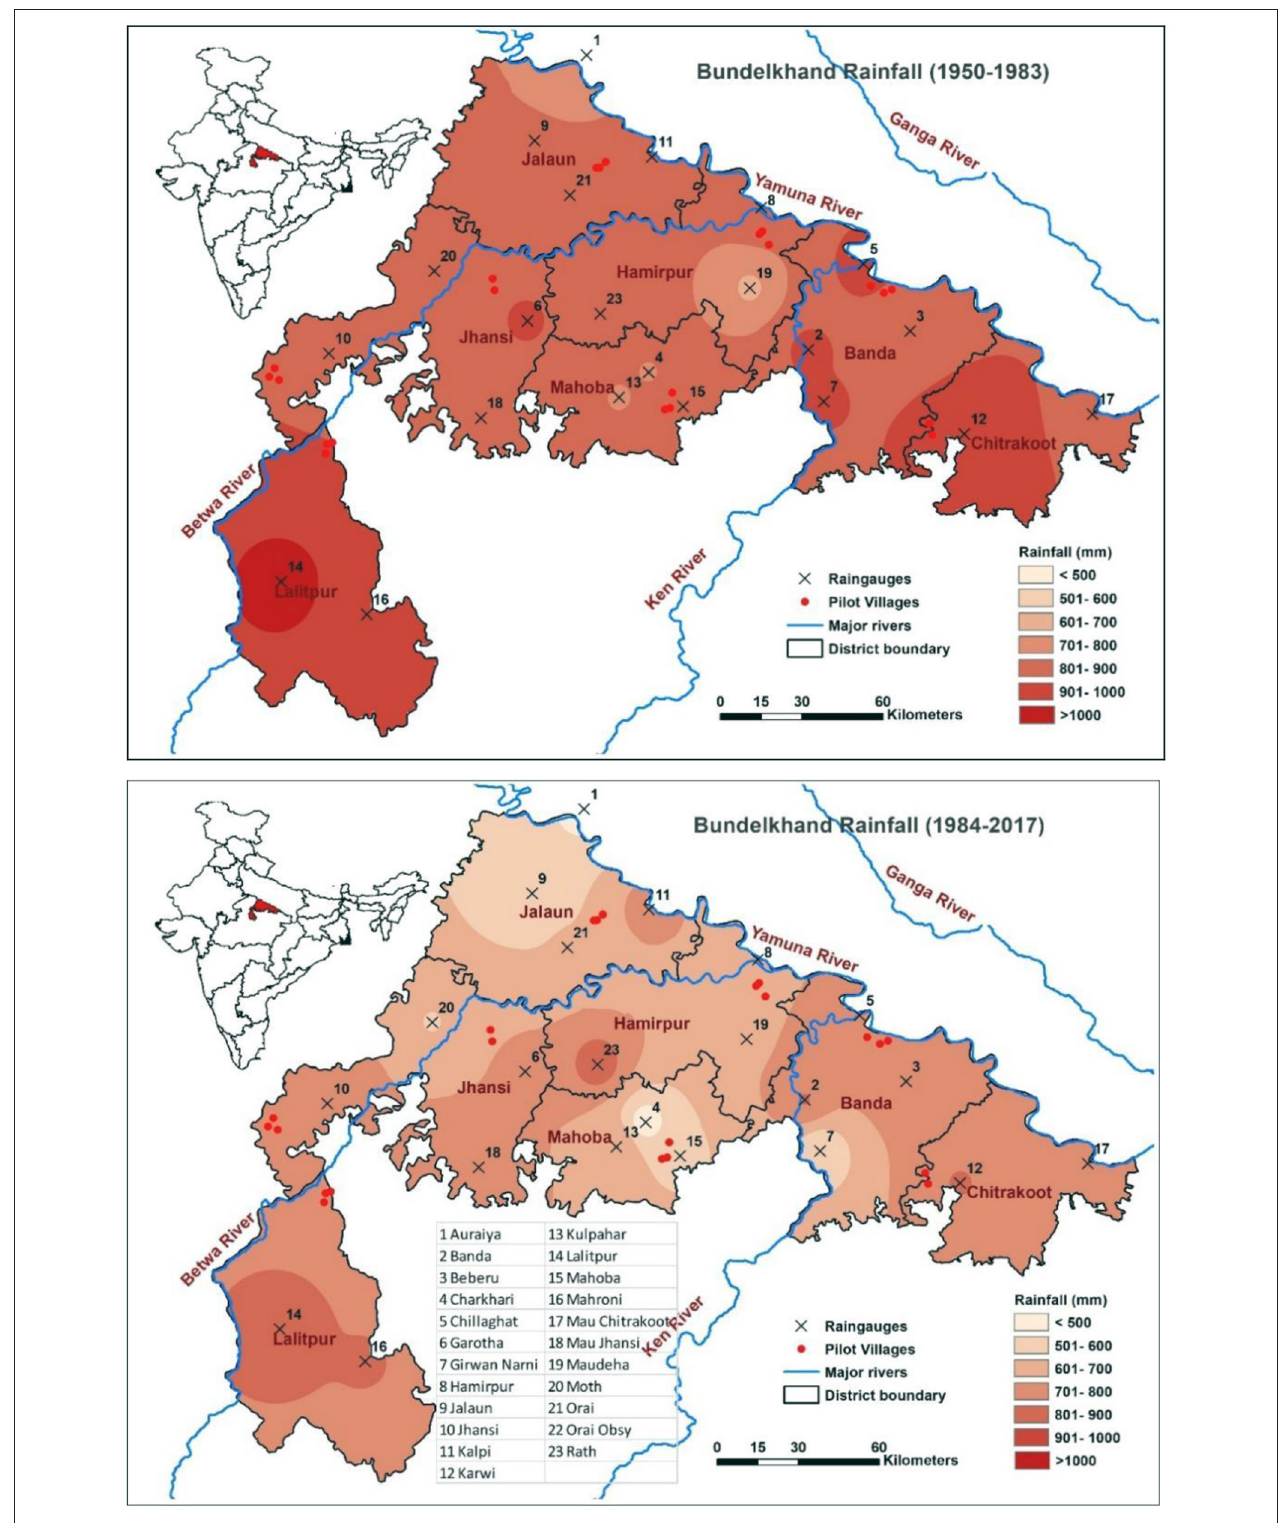
FIGURE 3 | Spatial and temporal variability of annual rainfall in Uttar Pradesh’s Bundelkhand region between 1950 and 2017.